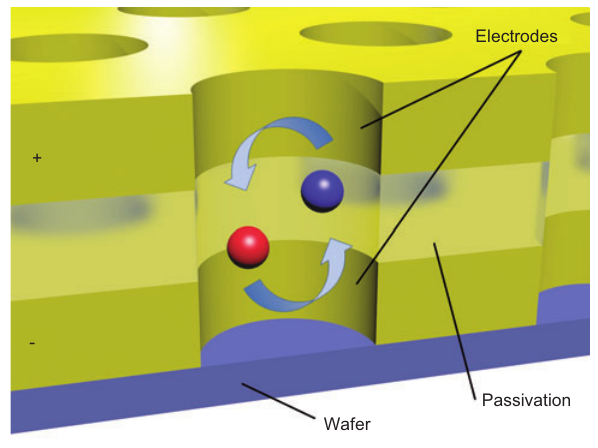
Figure 4 Illustration of a pore-based redox cycling sensor. Two porous metal electrodes are separated by an insulating layer. Redox- active molecules are indicated by the two colored spheres, whereas different colors represent different oxidation